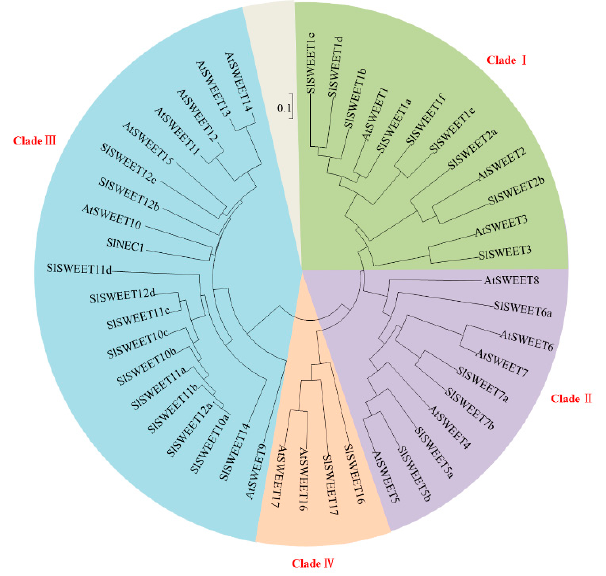
Figure 3. Phylogenetic analysis of SWEET proteins. The conservation of SWEET proteins from Arabidopsis thaliana ( At ) and Solanum lycopersicum ( Sl ) was assessed by phylogenetic tree analysis . A phylogenetic tree was constructed via the neighbor-joining method with 1000 bootstrap replications. The accession numbers are listed in Supplementary Table S1.